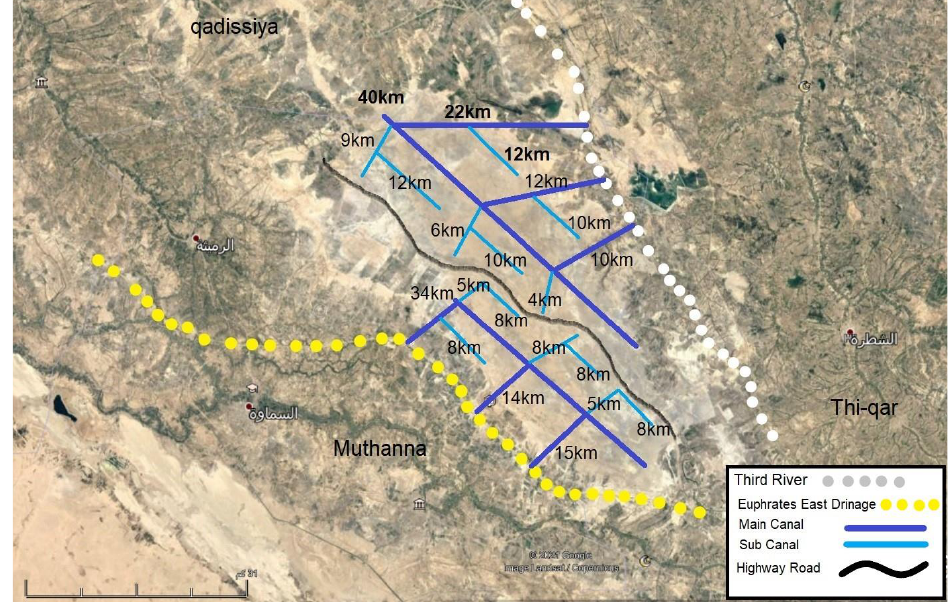
Figure 20. The general plan for draining channels from main streams and rivers for SDS hotspot